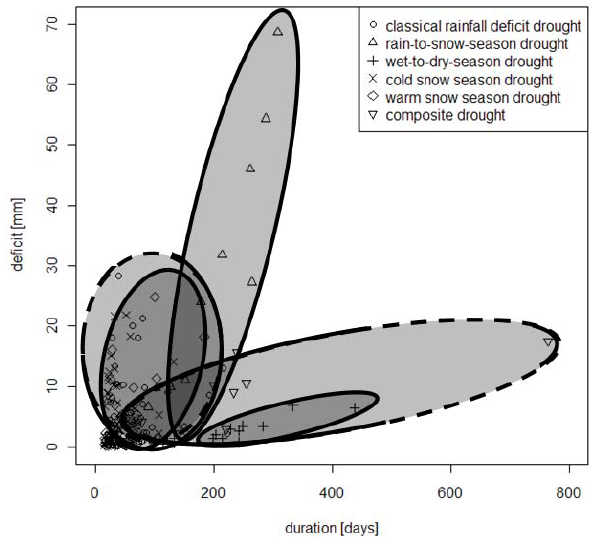
Fig. 11. Drought duration and deficit volume of all discharge drought events grouped per hydrological drought type (ellipses are added to more clearly identify groups of events with similar drought type; dashed lines indicate an approximation based on a single